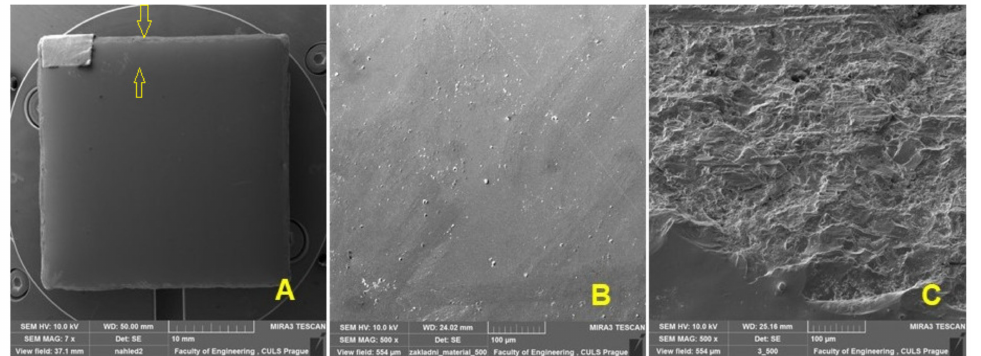
Figure 2. SEM analysis of the surface before wear: ( A ): produced test specimen (MAG 7 × ), ( B ): macro- scopic view of the enamel surface (MAG 500 × ), ( C ): surface texture visible after the cut made with the AWJ technology (MAG 500 ×